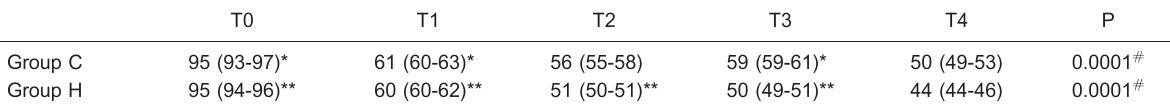
Table 4. IoC scale (EEG) in groups C and